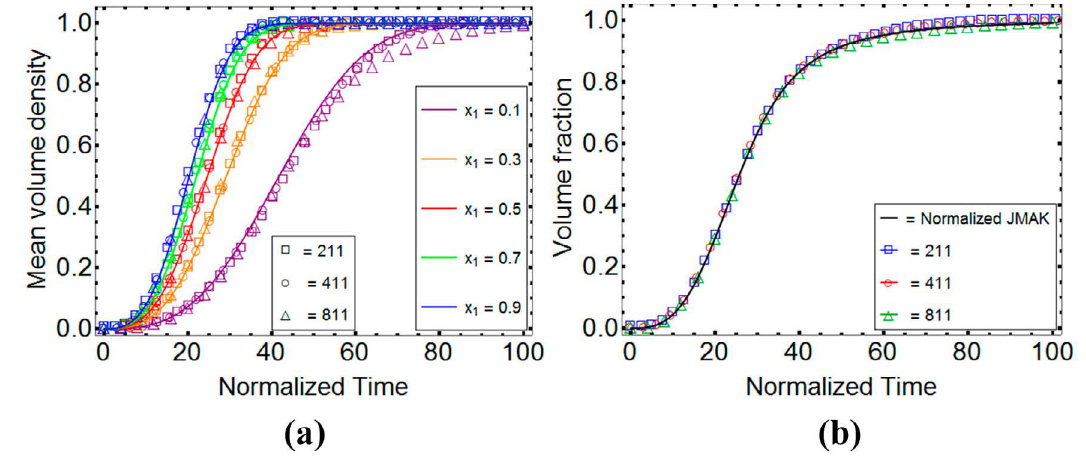
Figure 5. Transformation kinetics for prolate ellipsoids with aspect rations: 2:1:1, 4:1:1, 8:1:1. (a) Mean volume density as a function of normalized time; (b) Volume fraction as a function of normalized